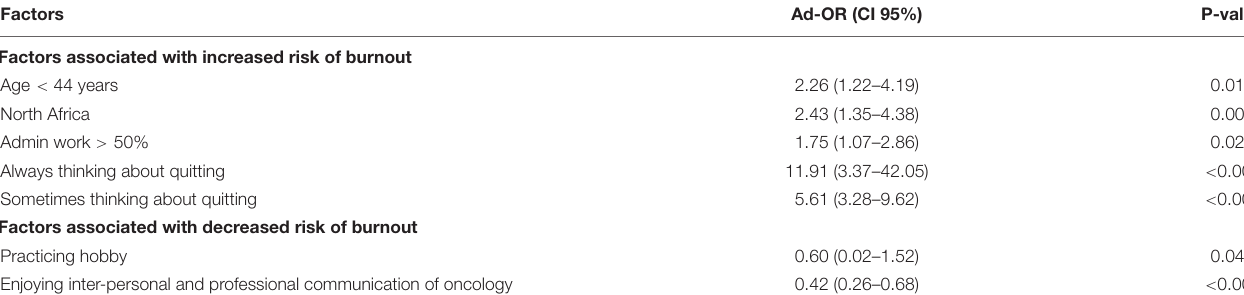
TABLE 2 | Multivariate logistic regression analysis for factors affecting the risk of developing burnout in female oncology physicians.